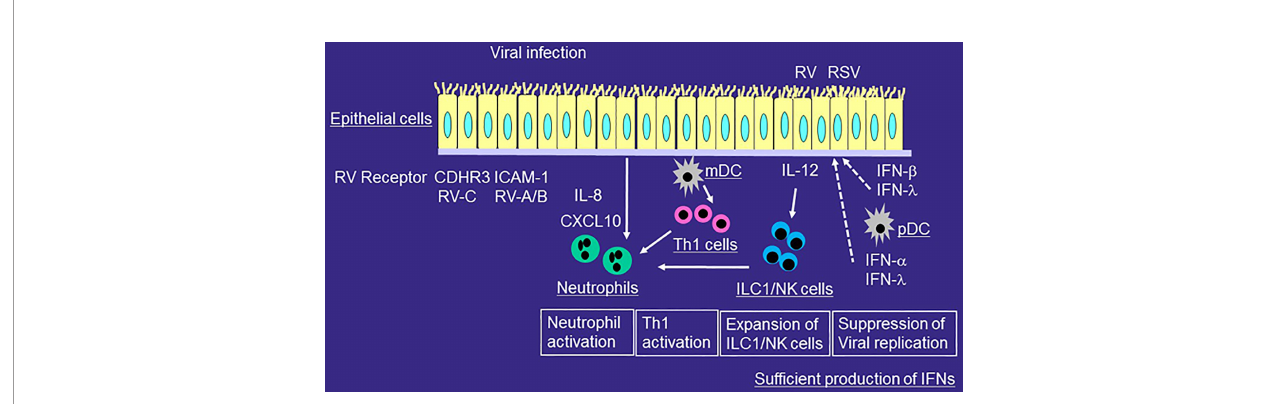
FIGURE 1 | Role of innate immune responses in the development of airway in fl ammation of healthy individuals during viral infection. RV or RSV infects airway epithelial cells and is taken up by receptor-mediated endocytosis. After recognition of virus components by PRRs, epithelial cells release proin fl ammatory cytokines and chemokines and antiviral cytokines including IFNs. mDCs present viral antigens to naïve T cells for differentiation, whereas pDCs produce IFN- a and IFN- l . The production of IFN from airway epithelial cells or pDCs is suf fi cient for viral immunity. RV or RSV infection induces more IL-12 expression in airway epithelial cells, and more ILC1 and NK cells in the airways. Viral infection releases IL-8 from epithelial cells and thus induces neutrophilic airway in fl ammation. Airway neutrophils disappears relatively quickly and eosinophilic airway in fl ammation is not usually